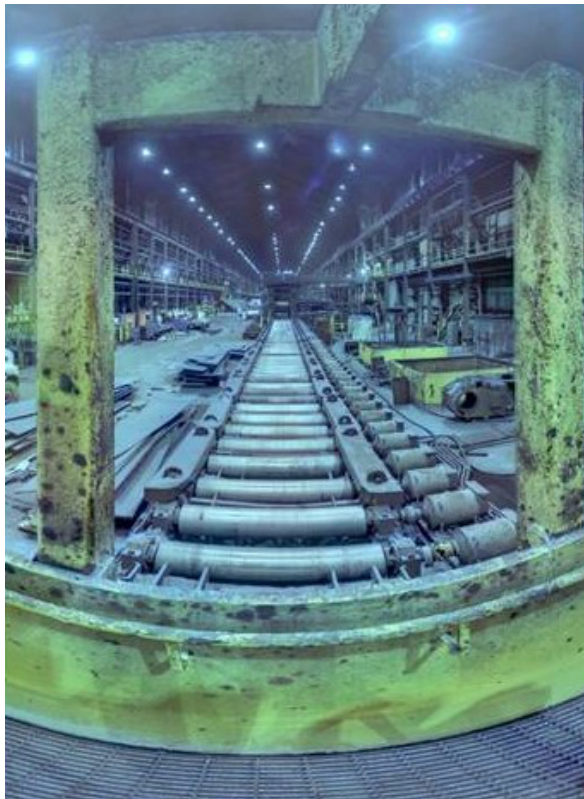
Figure 2. Rollers in a steel mill. Drive motors on the right side of the rollers.